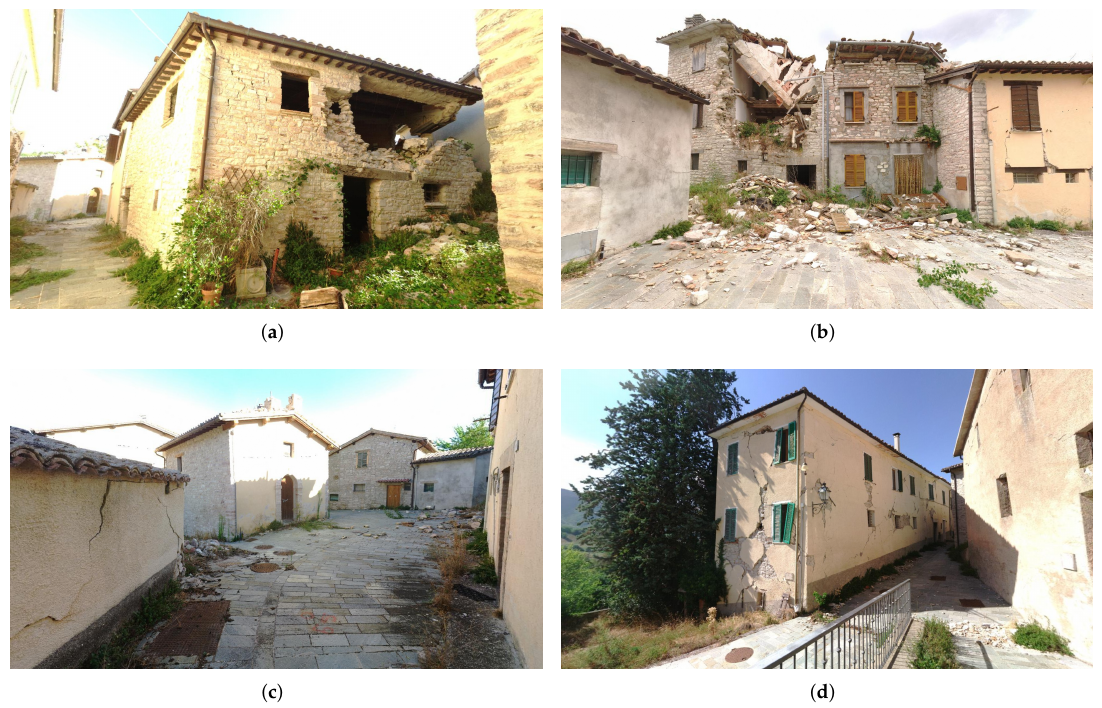
Figure 3. Damaged buildings in Gabbiano (Pieve Torina, Italy) on which is possible to observe different typologies of collapse. ( a ) Example of collapses stone Façade, ( b ) example of roof collapsed in stone buildings, ( c ) example of small urban area with cracks and ( d ) example of more recent building with